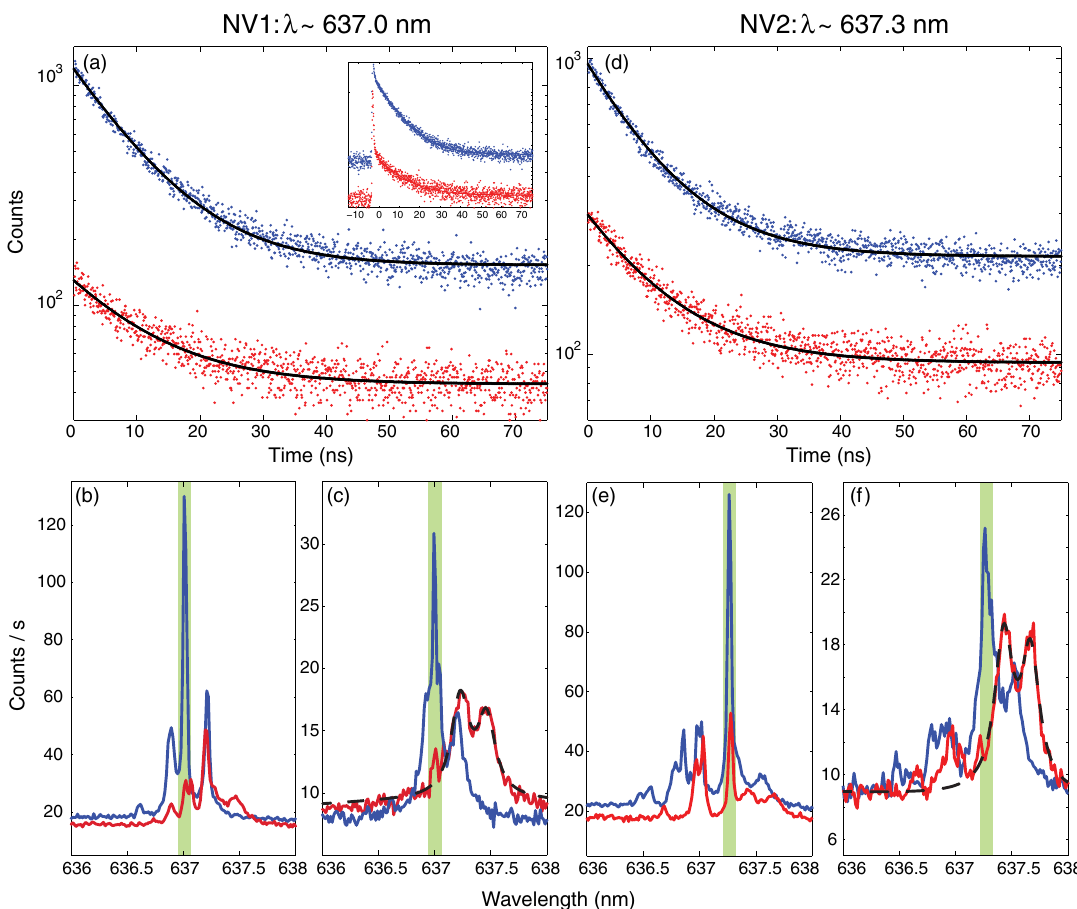
FIG. 3. (a) Time resolved photoluminescence of NV1 excited with a pulsed green source, when the NV1 ZPL is on (blue) and off (red) resonance with the nanocavity (cid:1) (cid:3) mode. The time origin is chosen (cid:1) 3 : 0 ns after the excitation pulse peak (see inset) so that fast decaying nanocavity background does not influence the fits (solid lines). Nanocavity spectra under (b) CW and (c) pulsed 532 nm excitation, when NV1 ZPL is on (blue) and off (red) resonance with the nanocavity mode. The green shaded regions indicate the monochromator spectral window used for the lifetime measurements in (a). The dashed line in (c) is a fit to the data consisting of two incoherently superimposed Lorentzian lineshapes. (d)–(f) Data analogous to (a)–(c), with the nanocavity (cid:1) (cid:3) mode tuned on and off resonance with the NV2